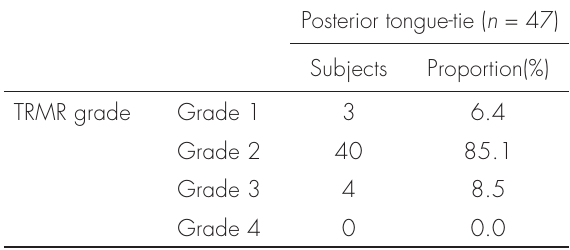
Table II. Correlation between the TRMR grade and clinical finding within patients with posterior